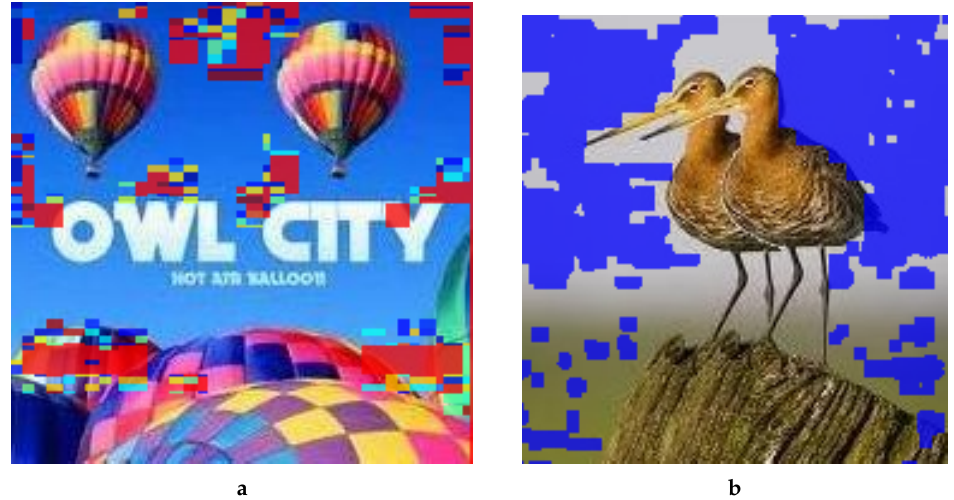
Figure 11. Forgery detection results provided by the authors of Mehmood’s method. ( a ) Forged balloon image, ( b ) Forged birds